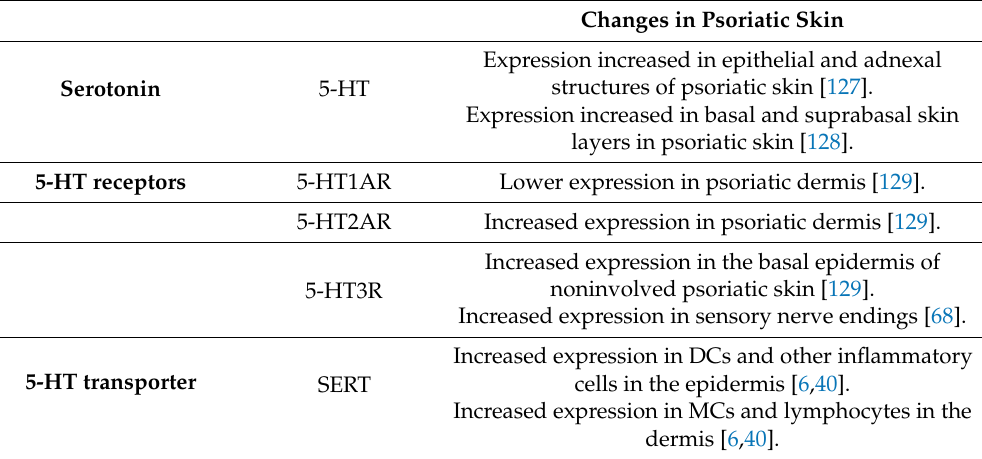
Table 3. Changes in the serotonergic system in psoriatic